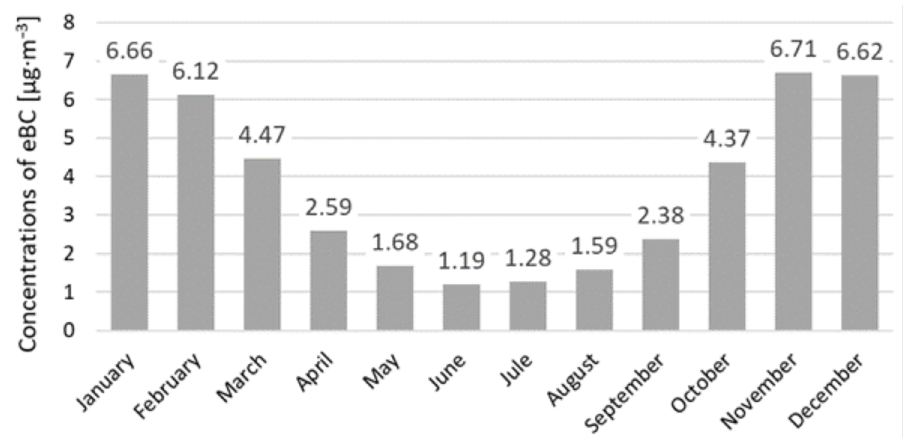
Figure 5. Monthly course of eBC concentrations ( µ g · m − 3 ) averaged over individual months.